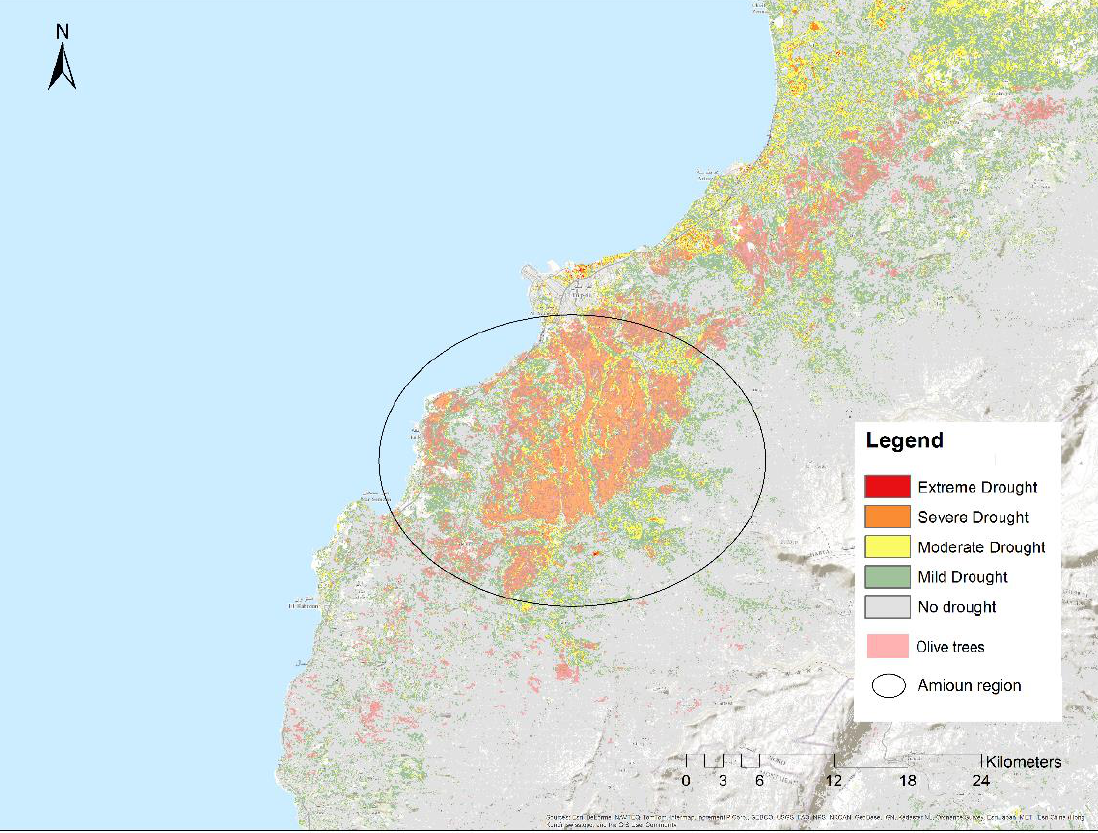
Figure 5. Olive tree repartitioning in the Amioun region on the VHI